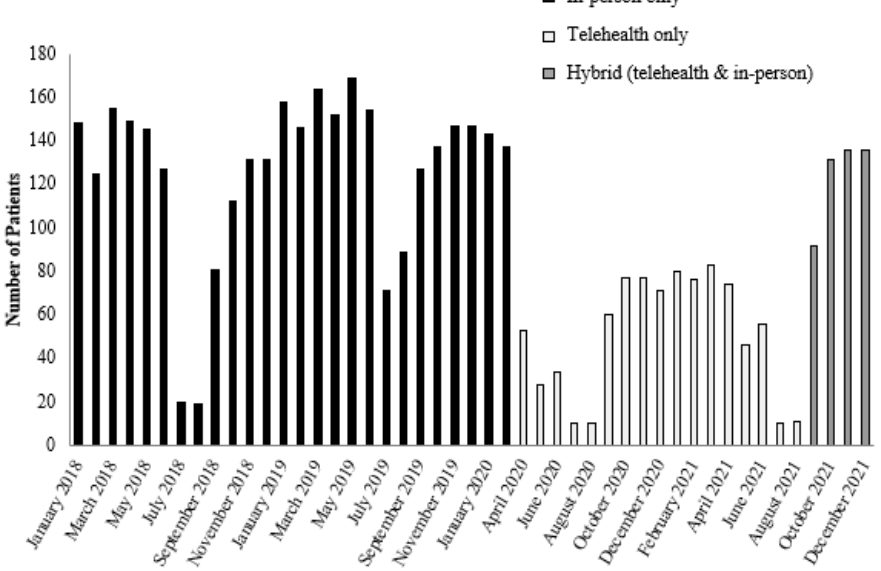
Figure 2. Total number of patients seen by month during periods of in-person care, telehealth only, and hybrid services. We conducted an ANOVA with service modality (in-person only, telehealth only, hybrid) as the independent variable and found a statistically significant difference F (2, 44) = 25.82, p < 0.001. Gabriel post-hoc tests revealed that telehealth only ( M = 50.35, SD = 27.79) resulted in a significantly lower number of patients being seen for behavioral health services compared with in-person only ( M = 126.31, SD = 39.58) and hybrid ( M = 123.75, SD = 21.30). There was no significant difference between in-person and hybrid. There was a 60% decrease in the average number of patients seen for behavioral health treatment when modalities of treatment changed from in-person care to telehealth. ANOVA analysis of pre-pandemic vs. pandemic status was also statistically signifi- cant F (1, 45) = 28.55, p < 0.001 with more patients being seen prior to the onset of the pan- demic ( M = 126.31, SD = 39.58) compared with during the pandemic ( M = 64.33, SD = 39.47). 3.3. Behavioral Health Referrals, Evaluations, Terminations, and Transfers Behavioral health referrals and new evaluations declined steeply following the onset of the pandemic (see Figure 3). There was a 70% decrease in referrals with 254 referrals for school-based behavioral health services in 2018 and 76 in 2020. Even after the schools and SBHCs returned to in-person behavioral health care, referrals did not reach pre-pan- demic levels. There were 160 referrals in 2021 compared with 254 referrals in 2018, demon- strating a 37% decrease overall. In 2021, our data demonstrated that the number of refer- rals outpaced the number of evaluations for the first time since 2018. At the same time, the number of terminations and transfers, both of which signify the end of care, decreased collectively, resulting in a waitlist for behavioral health care.